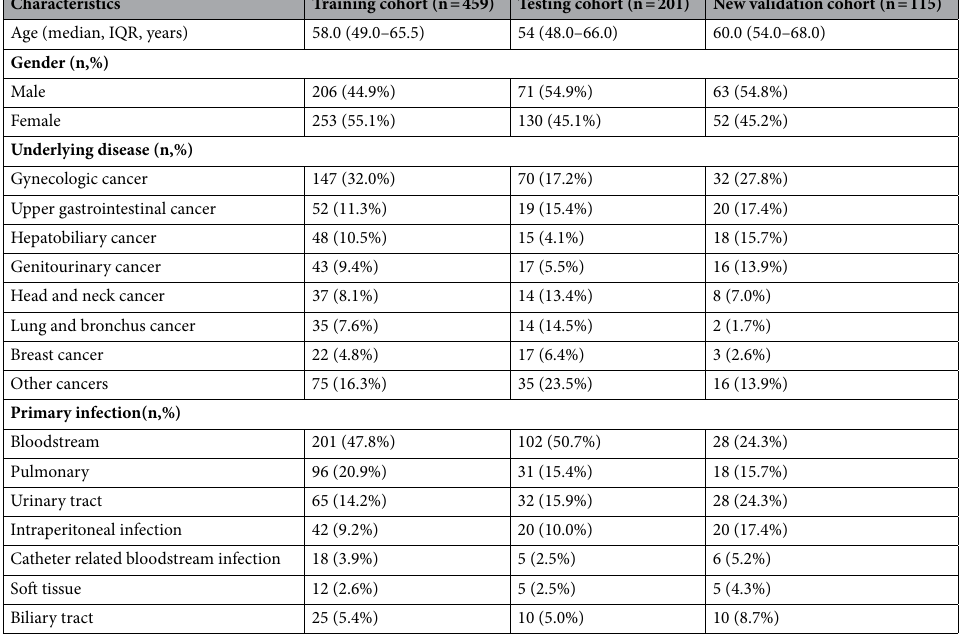
Table 1. Baseline demographics and characteristics of all patients in different data sets. IQR Interquartile